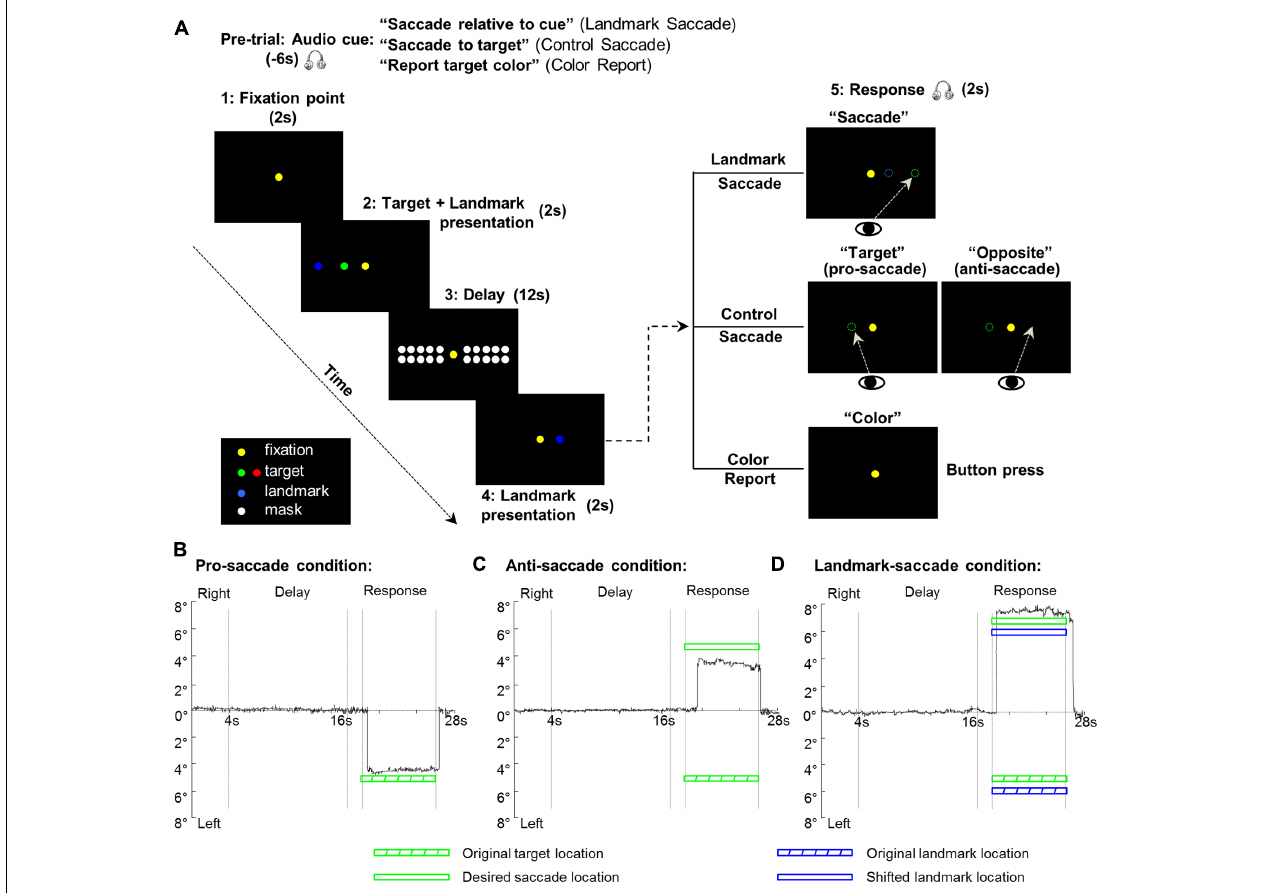
FIGURE 1 | Experimental paradigm and eye trajectories for each of the three saccade conditions from one representative participant. (A) The display of the visual stimuli is identical for the three tasks (Landmark Saccade, Control Saccade, and Color Report). The critical difference between the two saccade tasks is the reference frames used for the coding of target location for the upcoming saccade. In the Landmark Saccade task, target location is encoded relative to the landmark. In the Control Saccade task, target location is encoded relative to initial gaze position. In the Color Report task, the color of the target, rather than location, is being remembered and reported. (B) Eye trajectory for the pro-saccade condition in the Control Saccade task. The first and second vertical gray lines indicate onset and offset of the delay phase, respectively. The third and fourth vertical gray lines indicate start of a saccade response and end of the saccade by making gaze back to the central fixation point. (C) Eye trajectory for the anti-saccade condition in the Control Saccade task. Legends as in (B) . (D) Eye trajectory for the Landmark Saccade task. Legends as in (B)